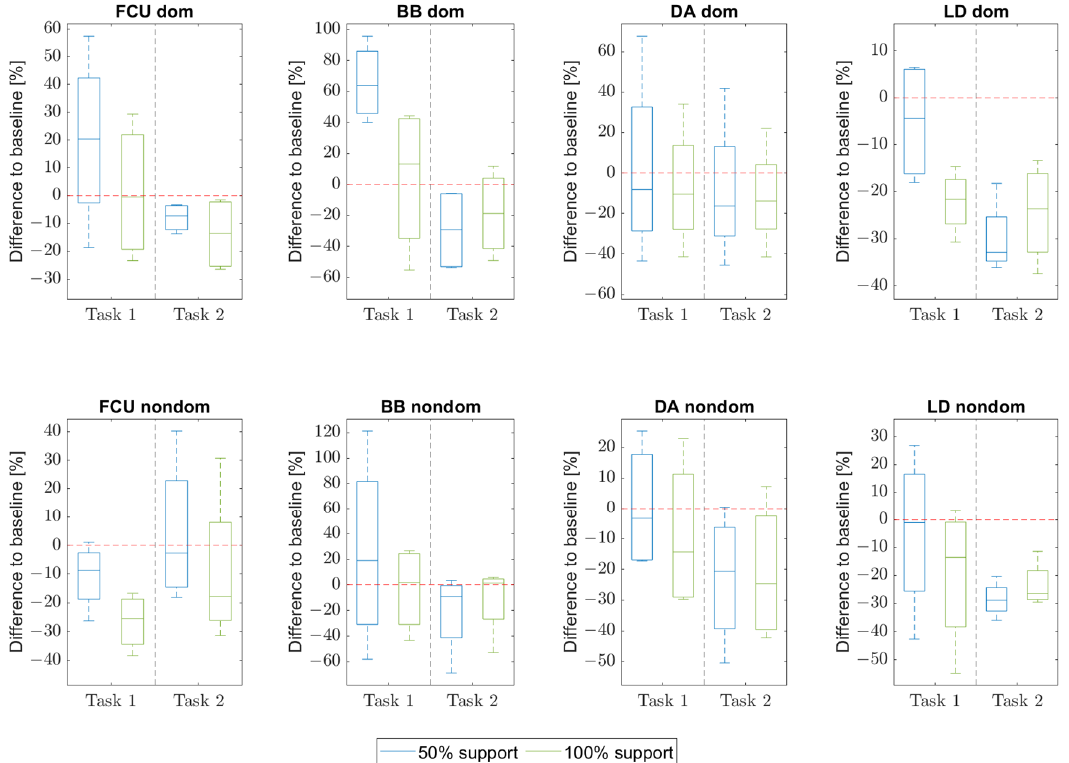
Figure 12. Differences in the mean EMGs of the eight muscles under conditions S50 and S100 compared to S0 during the screw phase in both tasks.